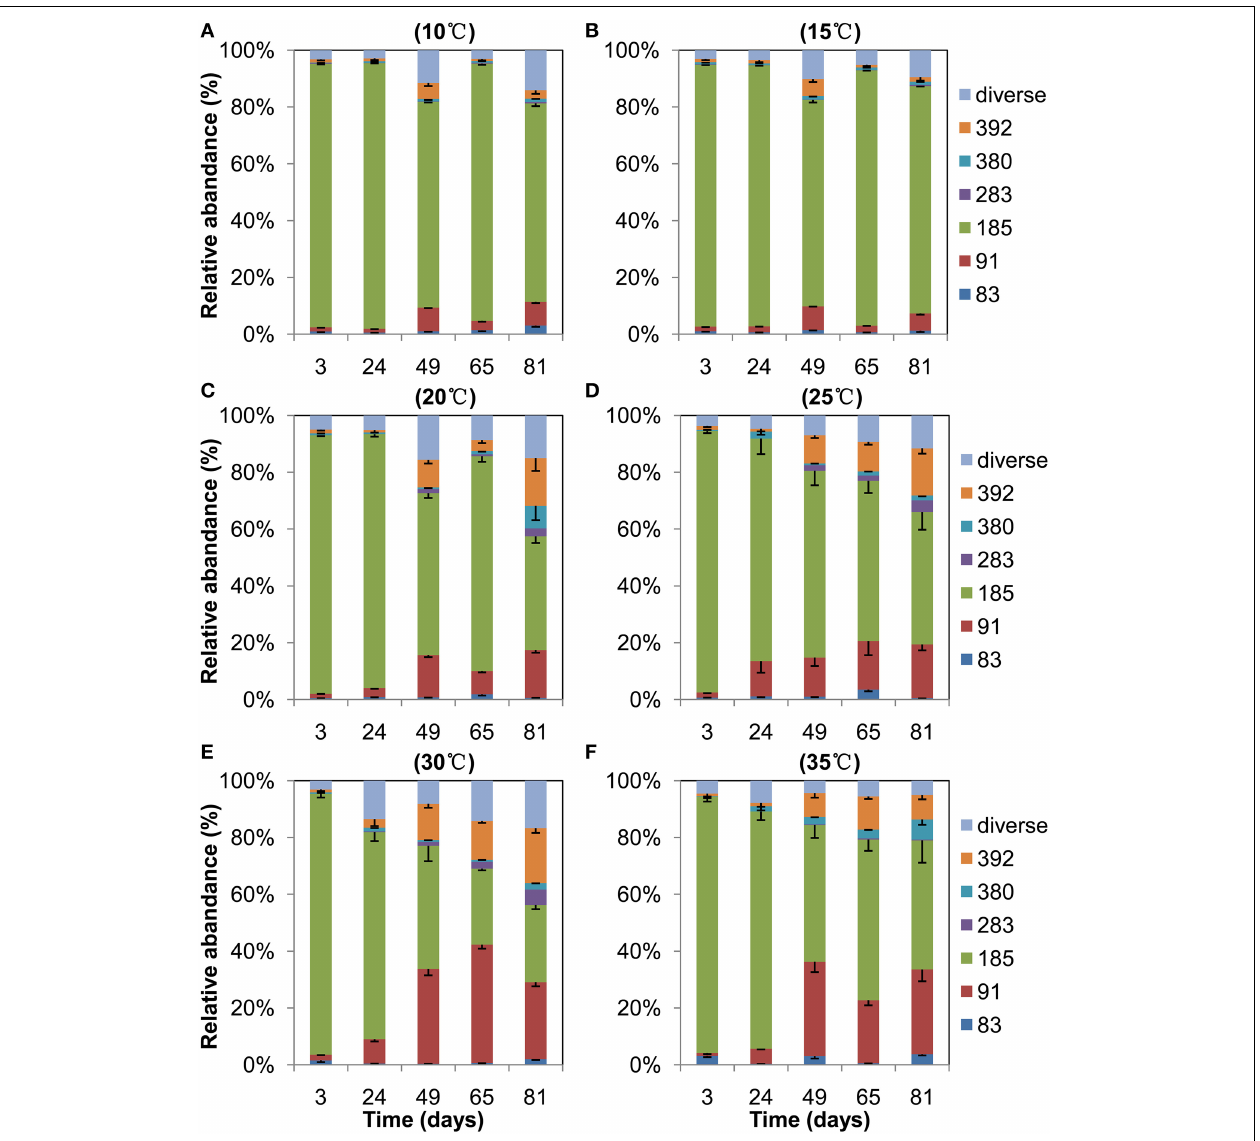
FIGURE 3 | T-RFLP profiles of the archaeal community in anaerobically incubated Zoige wetland soil at 10 ◦ C (A), 15 ◦ C (B), 20 ◦ C (C), 25 ◦ C (D), 30 ◦ C (E), and 35 ◦ C (F), respectively. Data are means minus standard error ( n = 3). Only major T-RFs are shown, the minor T-RFs are combined as